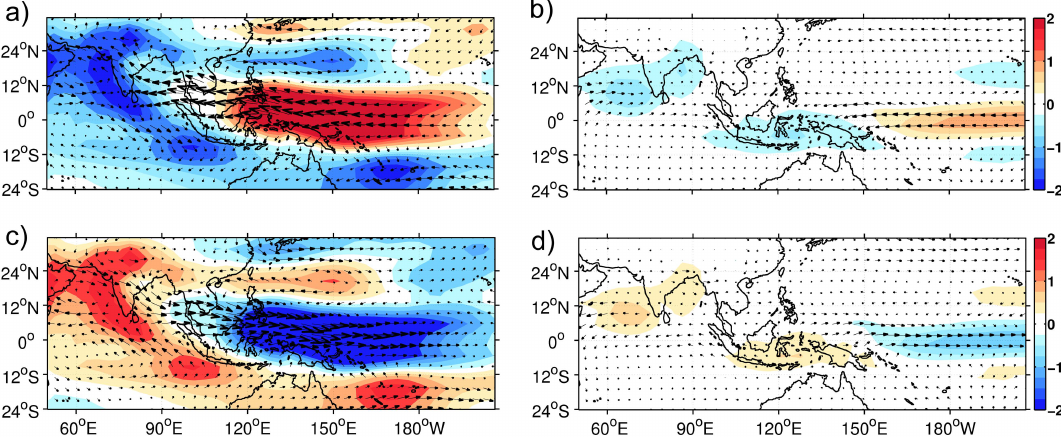
Figure 8. Model simulations’ composite anomalies of 850hPa wind (ms − 1 ) and OLR (Wm − 2 ) for the first ( a and b ) and second ( c and d ) regime from ECHAM5/MPIOM (left panels) and GISS-E2-R (right panels). The largest wind vector in the left panels is 0.6ms − 1 ; in the right panels it is 0.1ms − 1